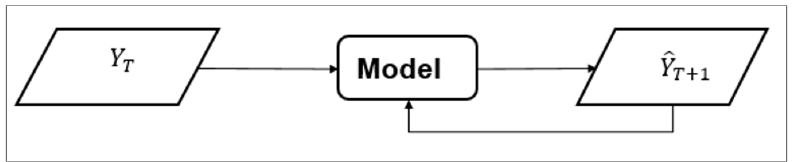
Figure 5. One-step prediction model.